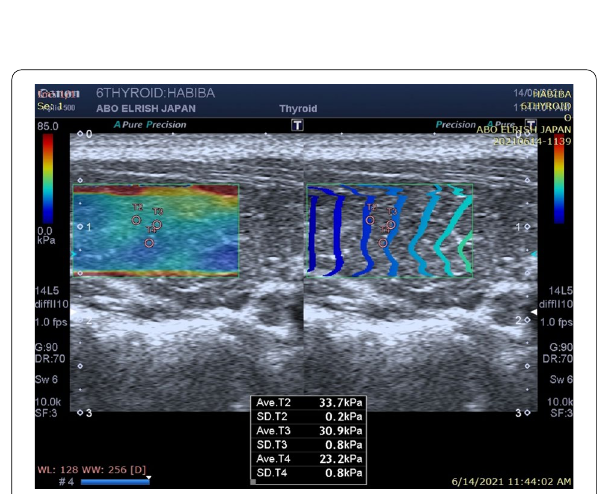
Fig. 2 Elastography of right thyroid gland measuring elasticity (33.7, 30.9 and 23.2